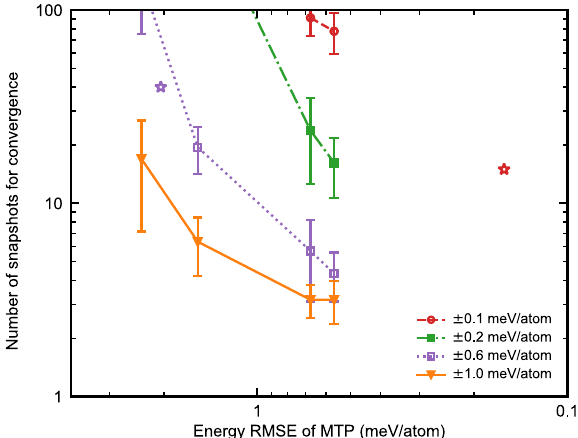
Fig. 3 Number of snapshots required for convergence of the direct upsampling as a function of the energy RMSE of the MTP. The colors represent different target accuracy as indicated in the legend. The symbols connected by lines denote upsampling to an Nb MTP model system. The purple and the red star show upsampling from MTP to DFT at T melt for Nb within ±0.6 meV/atom and for Mg within ±0.1 meV/atom, respectively. The error bars denote a 95% con fi dence interval derived from independent sets of